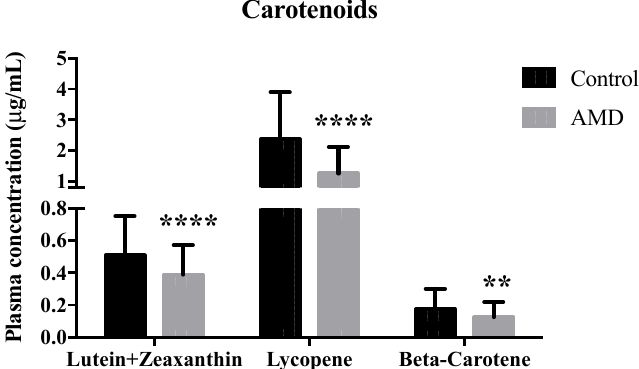
Figure 1. Plasma concentration of carotenoids in healthy control and patients with wet age-related macular degeneration (AMD). Values are expressed as mean ± SD. ** P < 0.01 and **** P < 0.0001 versus healthy control. Table 2. Plasma concentration of fatty acids in healthy control and wet AMD patients.